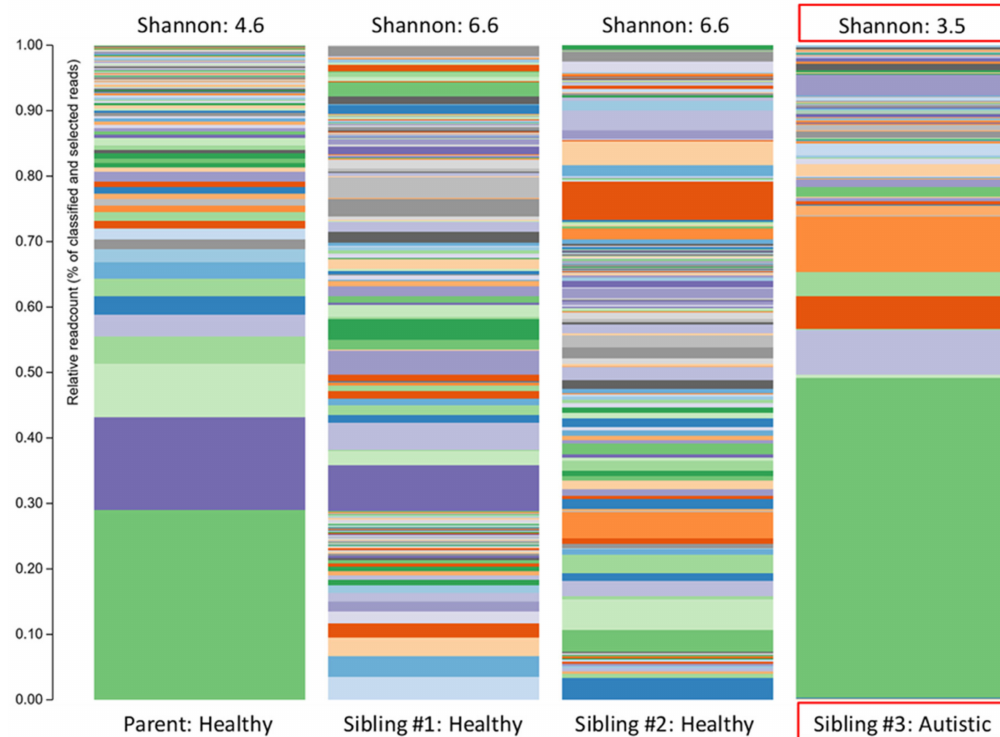
Figure 1. The stacked bar plots show the bacterial alpha diversity in the gut microbiome of a patient with autism spectrum disorder (Sibling #3) and the patient’s healthy biological triplet siblings and mother. Alpha diversity was quantified using the Shannon Index.